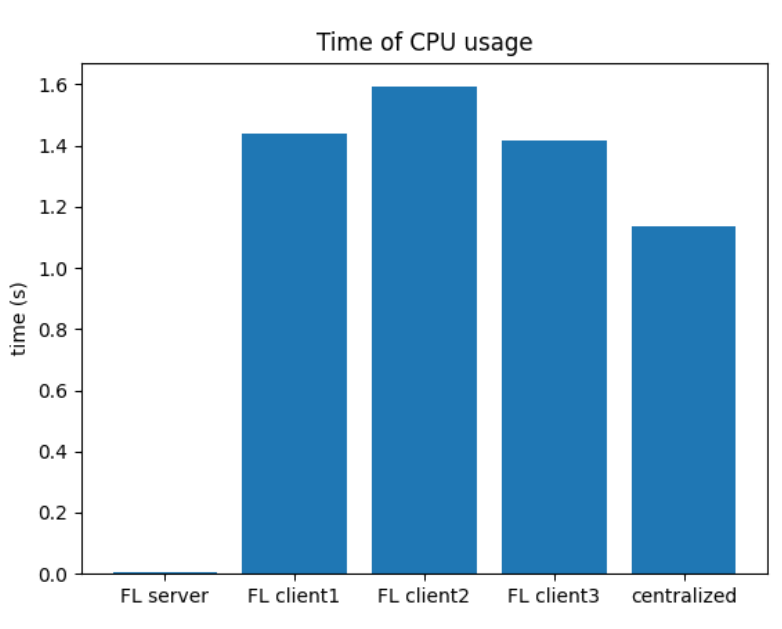
Figure 6. CPU usage time histogram for federated and centralized processes.